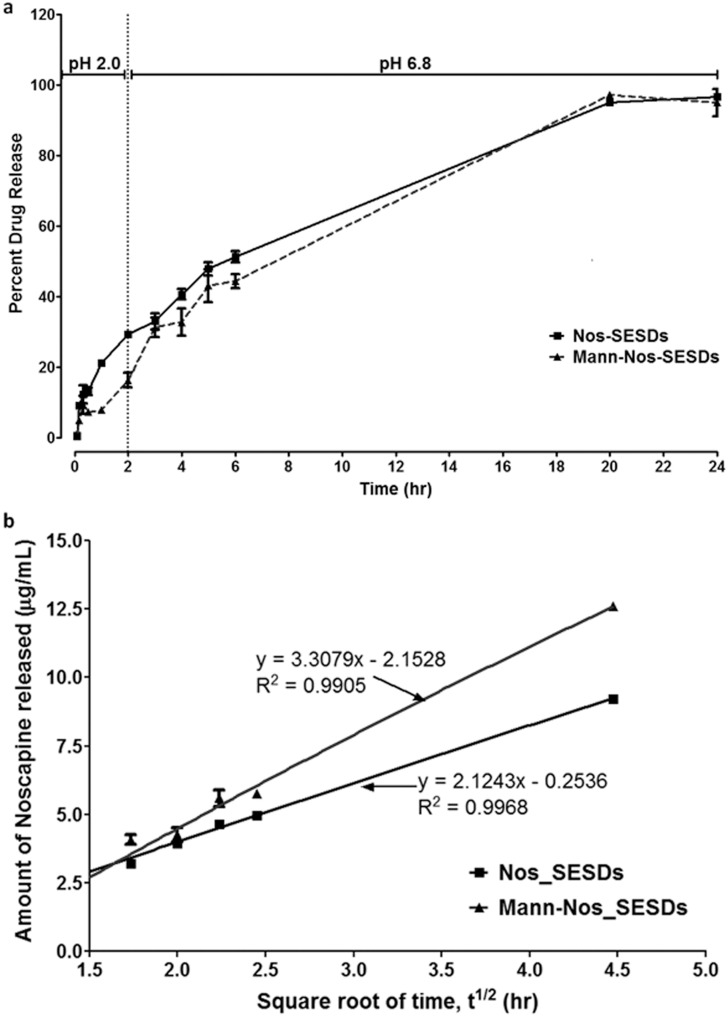
Mannosylated microparticle retaines 50% of oral noscapine in 6 hours.(a) The dissolution rate and release of total noscapine from HPMC-coated spray-dried Nos_SMEDD and Mann-Nos_SMEDD are shown in simulated gastric (pH 2.0) and intestinal (pH 6.8) buffers from 5 min to 24 hr. Results were presented as mean percent of Nos release vs time. (b) Kinetic release of Nos_SMEDD and Mann-Nos_SMEDD showing Higuchi relationship of drug amount released from solid microparticle into dissolution buffer against square root of time. Straight line equation obtained by linear regression. Both formulations were linear with R2 ranging between 0.9905 and 0.9968. Data represents 6 replicates of experiments repeated 2× and differences were not considered significant.